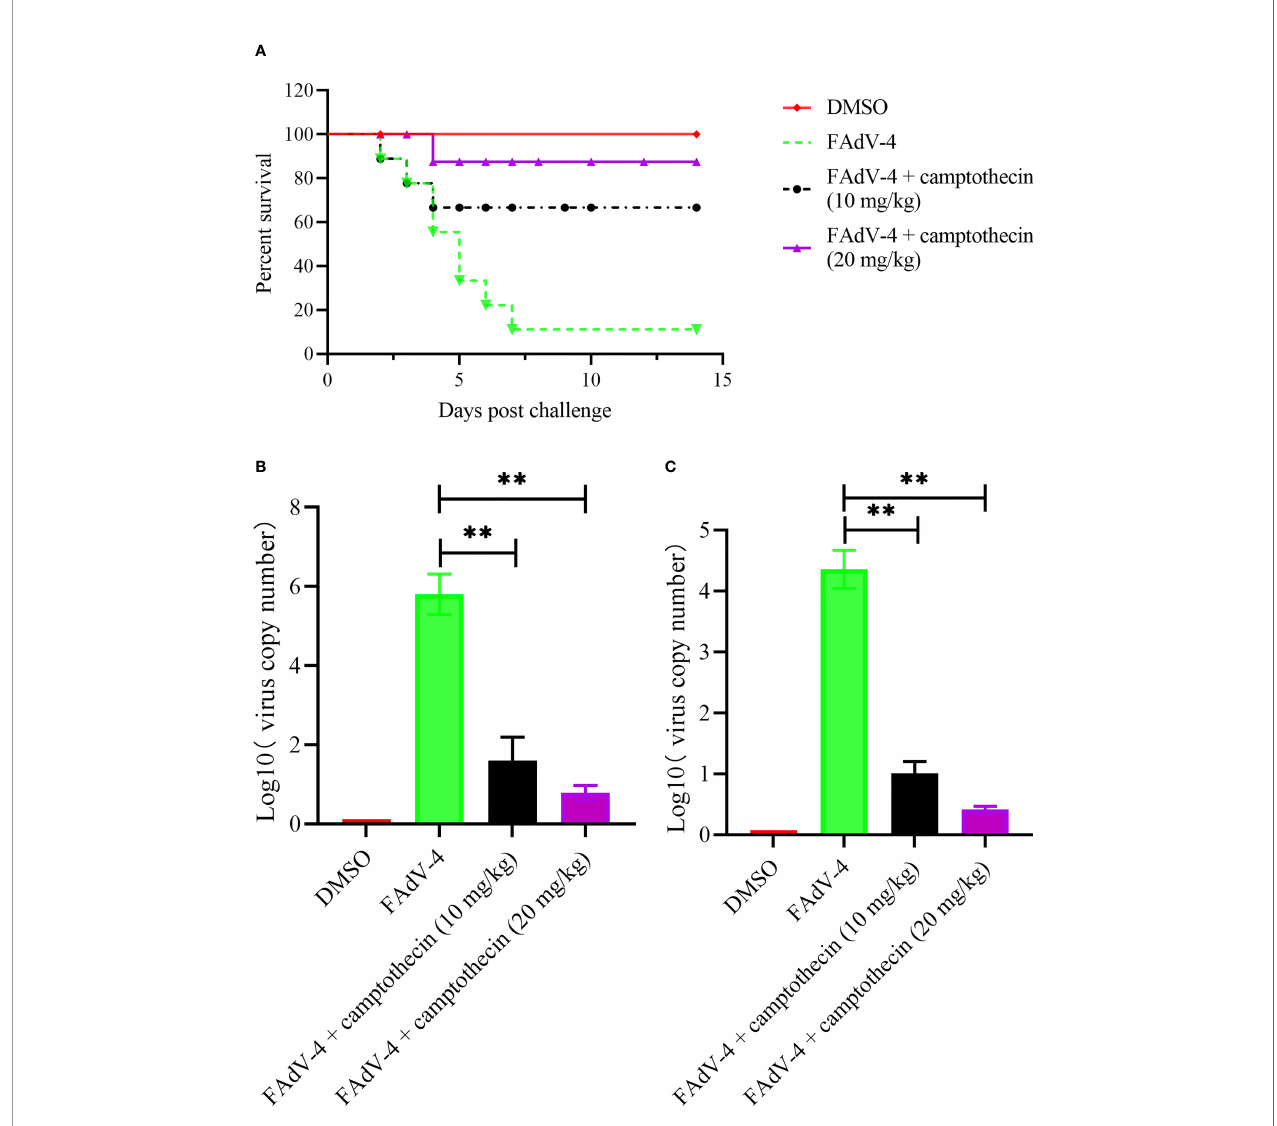
FIGURE 4 | Camptothecin inhibited FAdV-4 infection in vivo . Chickens were infected with FAdV-4 at 4 h before the beginning of the camptothecin treatment. (A) Survival rate was measured for 2 weeks. (B, C) Virus copy numbers in the liver and kidney were detected using qPCR in all chicken groups. All experiments were performed in triplicate ( n = 3). Error bars represent the standard deviation. The asterisks in the fi gures indicate signi fi cant differences (** P <